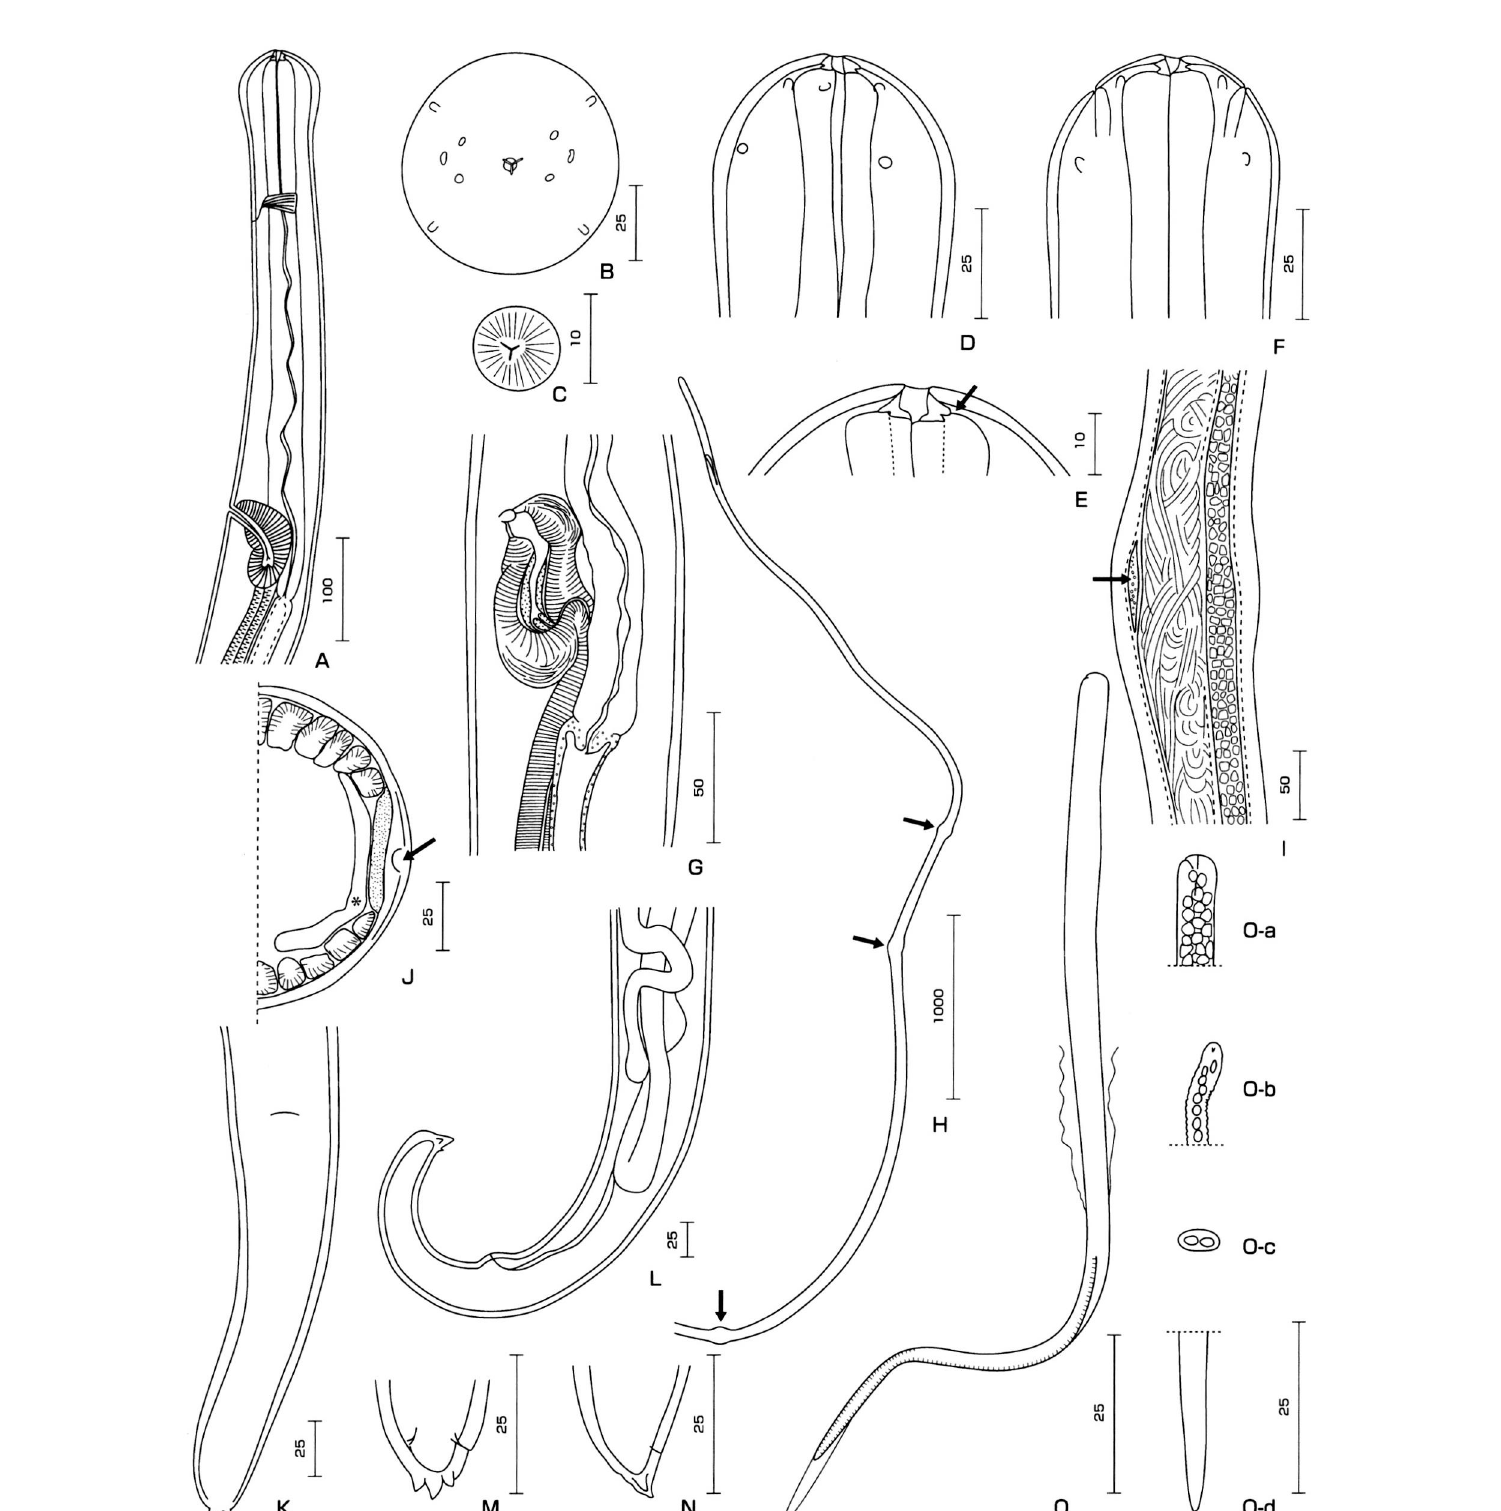
Fig. 1. - Cercopithifllaria longa n. sp. A-N, females. A. Anterior part, lateral view. B. Head, en face view. C. Transverse section of eso­ phagus at base of the buccal capsule. D. Head, lateral view. E. Buccal capsule, lateral view. External crest (arrow). F. Head, median view. G. Vagina, subventral view. H. Anterior part with body swellings (arrows). I. A body swelling with a pseudocoelomocyte (arrow). J. Trans­ verse section of a swelling, with part of a pseudocoelomocyte (*), lateral chord (with small dots), and lateral internal thickening (arrow). K. Tail, ventral view. L. Posterior part, lateral view. M. Caudal extremity, ventral view. N. Caudal extremity, lateral view. O-O-d. Microfi­ lariae. O. Entire body with sheath. O-a. Anterior end, dorsal view. O-b. Anterior end. left lateral view. O-c. Midbody, transverse section. O-d. Caudal part, median view. Bars,